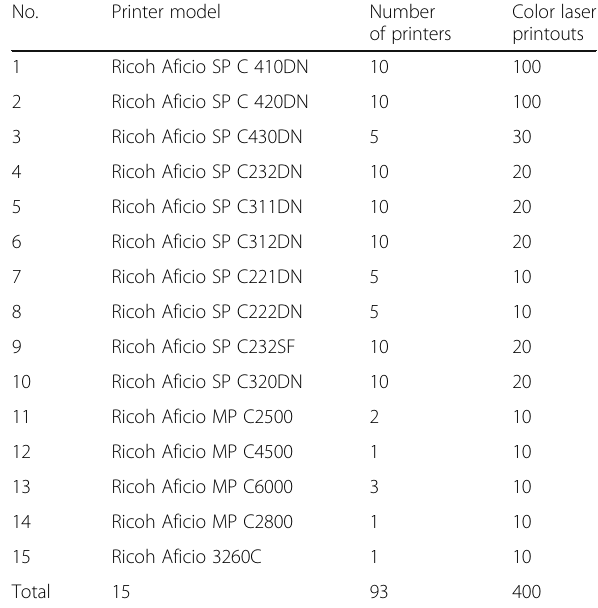
Table 1 Color laser Ricoh ® printer models ’ candidate for